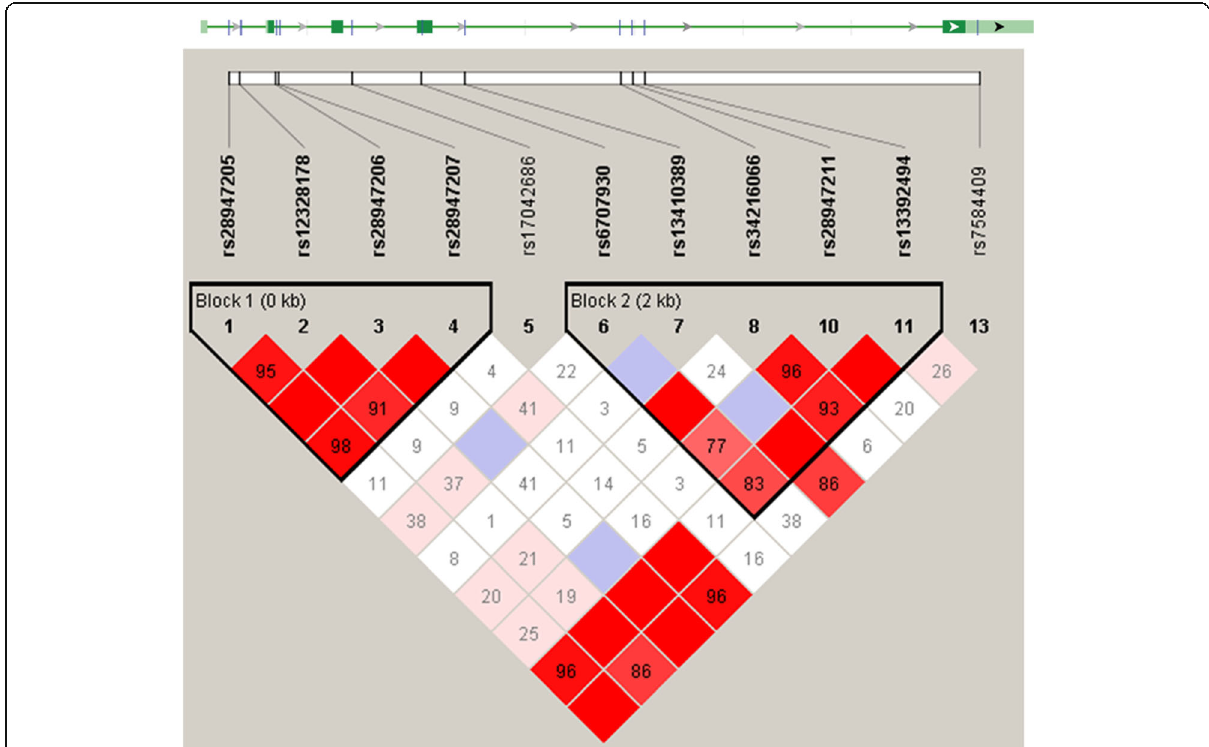
Fig. 1 IL36G gene and genotyped SNPs. The image of LD pattern was generated using the Haploview v4.2 program and black boxes indicate haplotype blocks in entire psoriasis